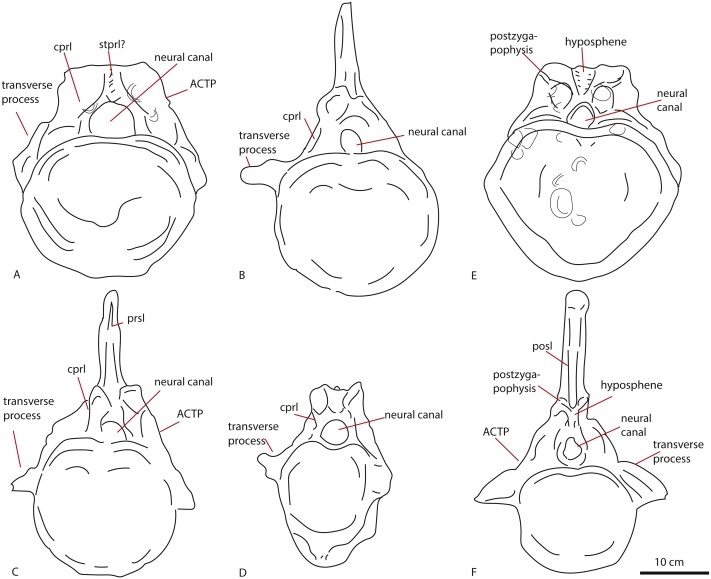
Comparative schematic drawings of PETMG R272 with anterior caudals of other sauropods.PETMG R 272 in anterior view (A) with Cetiosaurus oxoniensis (B), Cetiosauriscus (C) and an indeterminate non-neosauropod eusauropod from the Middle Jurassic of the UK (YORYM:2001.9337; Manning, Egerton & Romano, 2015), (D). PETMG R272 in posterior view (E) compared to NHMUK R1984 (F) in posterior view (after Noè, Liston & Chapman, 2010). Scalebar 10 cm, Cetiosauriscus and NHMUK R1984 not to scale.